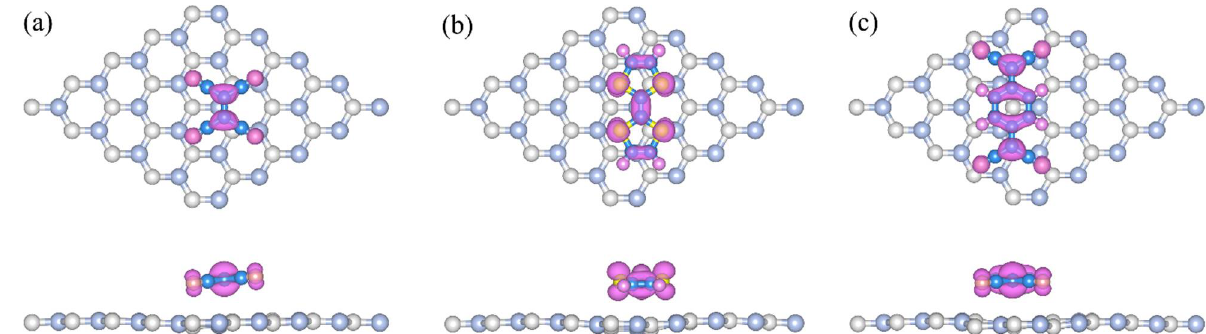
Figure 5. Band structures of ( a ) intrinsic g−ZnO, ( b ) TCNE/g−ZnO, ( c ) TTF/g−ZnO, and ( d ) TCNQ/g−ZnO. The Fermi level is moved to zero, represented by the black dash line.